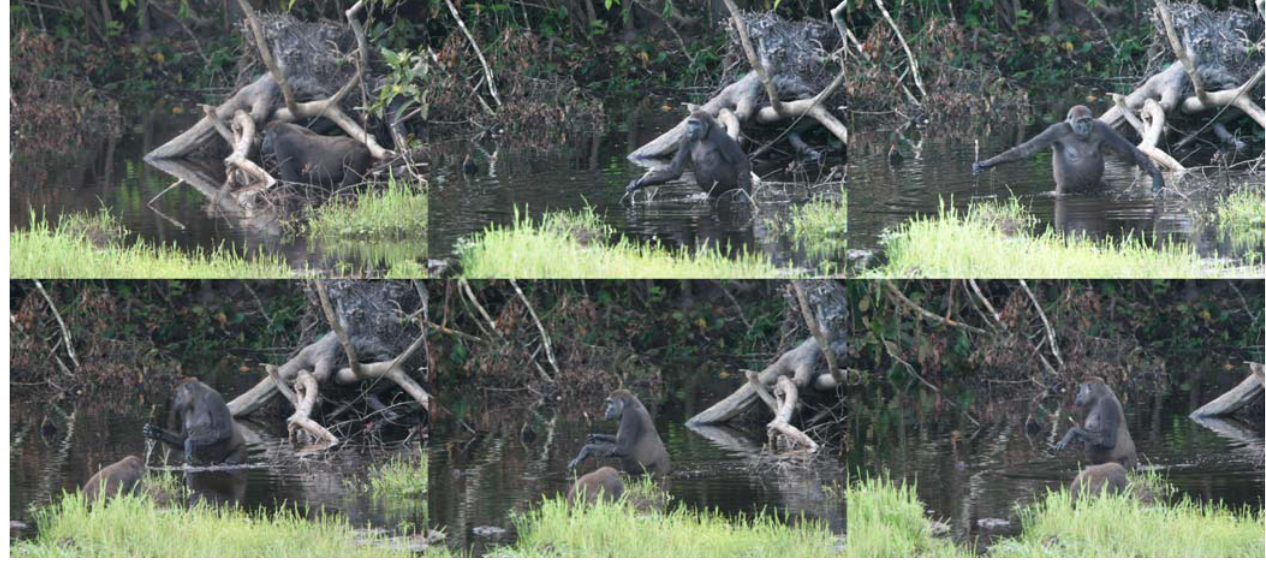
Figure 1. Female Leah Using a Walking Stick while Crossing Bipedally through an Elephant Pool at Mbeli Bai Female Leah first looked at the new elephant pool and the branch she later used as the walking stick, and entered the water without the tool (not shown). After re-entering the pool and taking the branch with her right hand, she walked bipedally 8–10 m into the water, frequently testing water deepness. DOI: